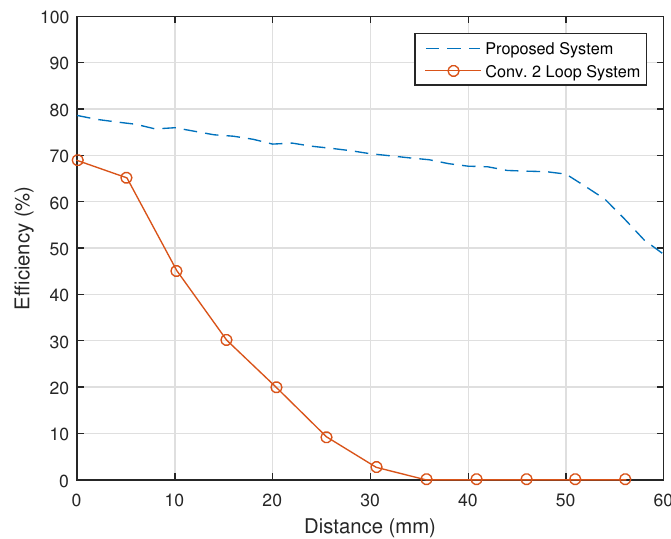
Figure 18. The efficiency of the proposed charger based on misalignment from the